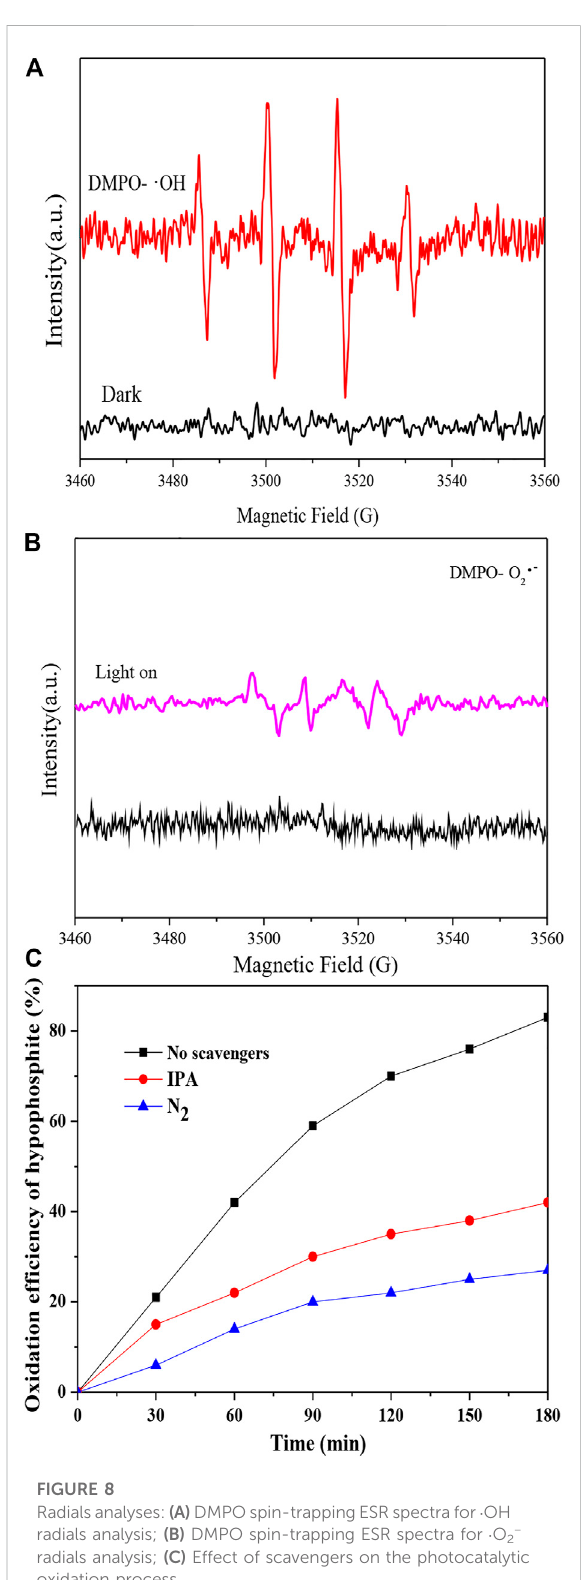
FIGURE 8 Radialsanalyses: (A) DMPOspin-trappingESRspectrafor · OH radials analysis; (B) DMPO spin-trapping ESR spectra for · O 2 − radials analysis; (C) Effect of scavengers on the photocatalytic oxidation